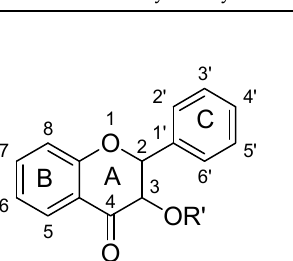
Table 4. Flavanonols and their Structure activity relationship. Sr. No.